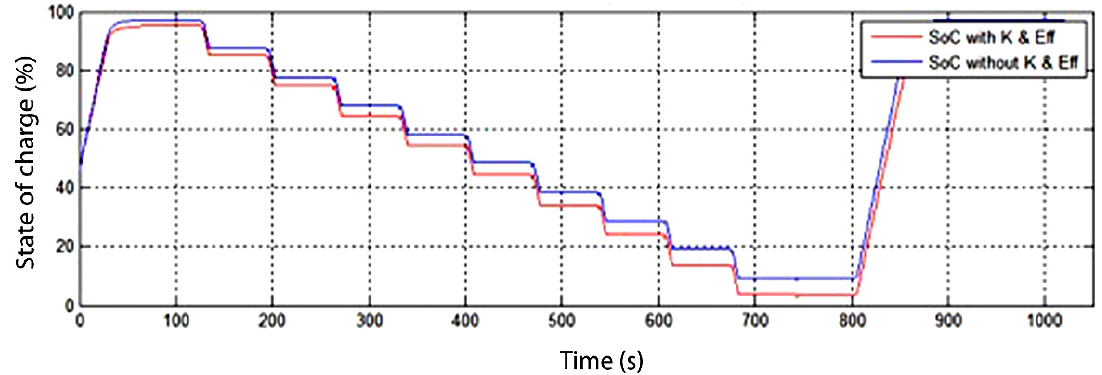
Figure 7. State of charge estimation including Peukert and